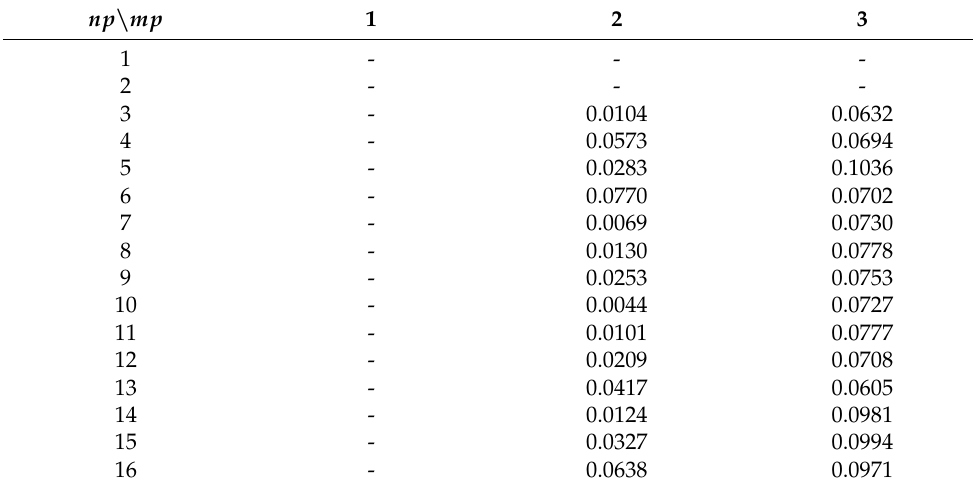
Table 6. Newton errors of the last iteration for u x obtained with Legendre collocation with a mesh 16 × 10 varying the number of horizontal ( np ) and vertical ( mp ) subdomains; Ra = 1300 and Γ =